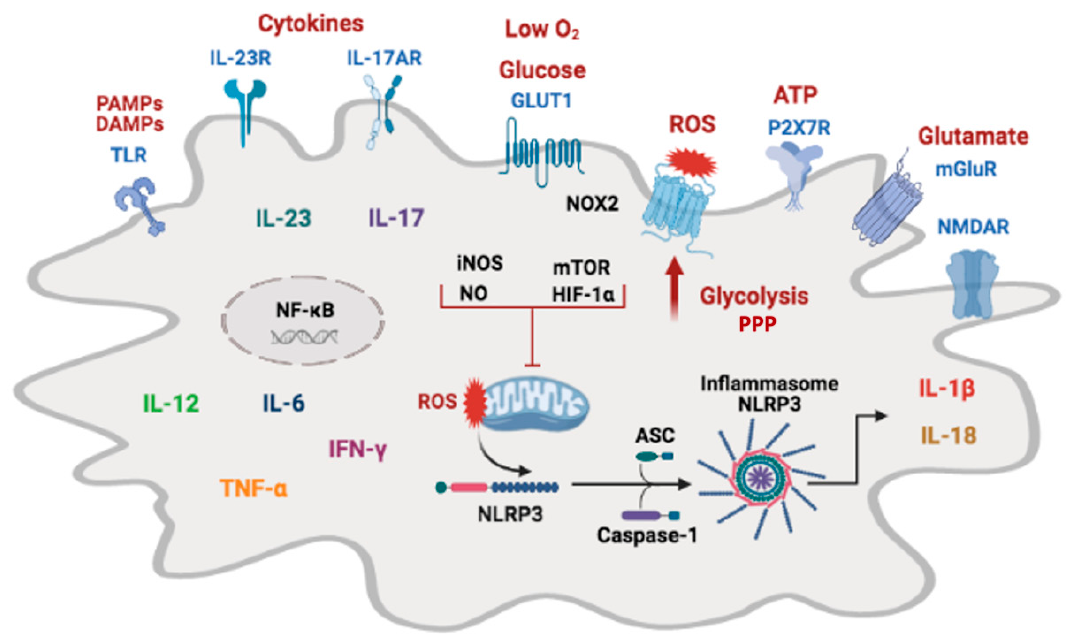
Figure 2. Molecular mechanisms of microglia activation in sepsis-associated encephalopathy. Classically (M1) activated microglia express Toll-like receptors (TLR) that recognize pathogen-associated molecular patterns (PAMPs) and damage-associated molecular patterns (DAMPs) and trigger NF- κ B-dependent pro-inflammatory gene expression, upregulating inflammatory cytokines such as IL-6, IL-12, TNF- α , and IL-23 and components of the inflammasome pathway. IL-23 mediates inflammatory response by inducing IL-17 production and the secretion of pro-inflammatory cytokines. Inducible NOS is upregulated in M1 microglia, and NO induces a metabolic shift to glycolysis through mitochondrial inhibition. Inflammation and hypoxia activate the mTOR/ HIF-1 α pathway, inhibit mitochondrial oxidative phosphorylation, and increase glycolysis. GLUT1 is upregulated to increase glucose uptake by M1 microglia. Glucose oxidation through the pentose phosphate pathway (PPP) generates NADPH, which is the substrate for NOX2 and iNOS to produce ROS and NO, respectively. P2x7, the ATP receptor activation, and mitochondrial ROS trigger NLRP3 inflammasome activation and IL-1 β and IL-18 release. Activation of microglial metabotropic (mGluR) and N-methyl-D-aspartate (NMDA) glutamate receptors (NMDAR) trigger M1 polarization. ASC, adaptor molecule apoptosis-associated speck-like protein containing a CARD.